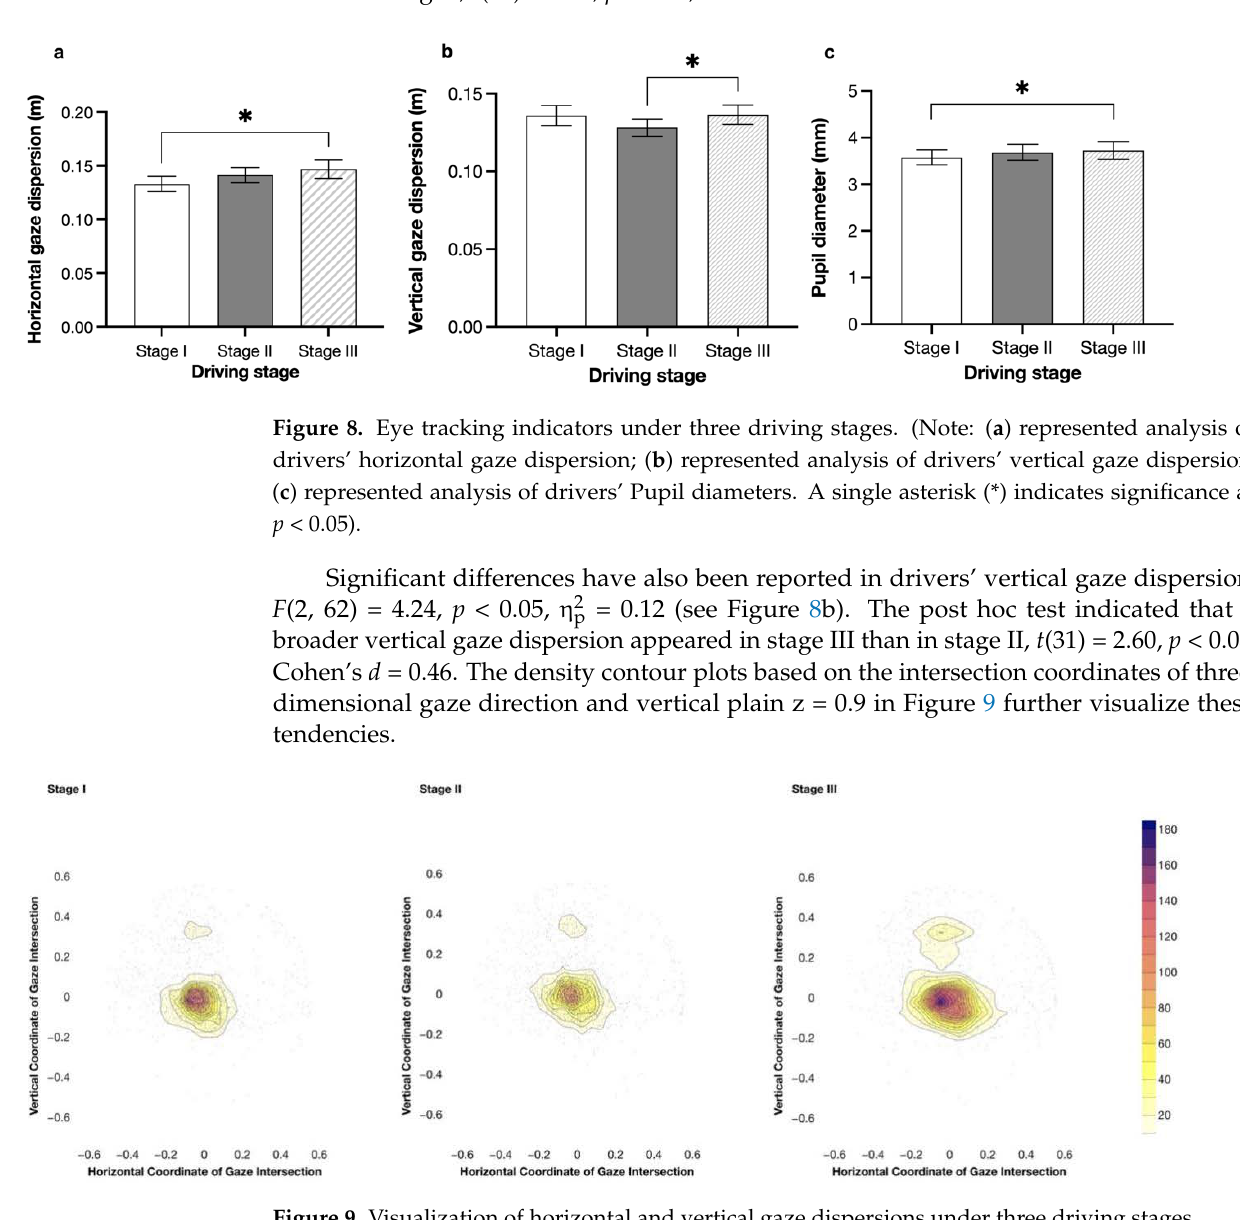
Figure 9. Visualization of horizontal and vertical gaze dispersions under three driving stages.